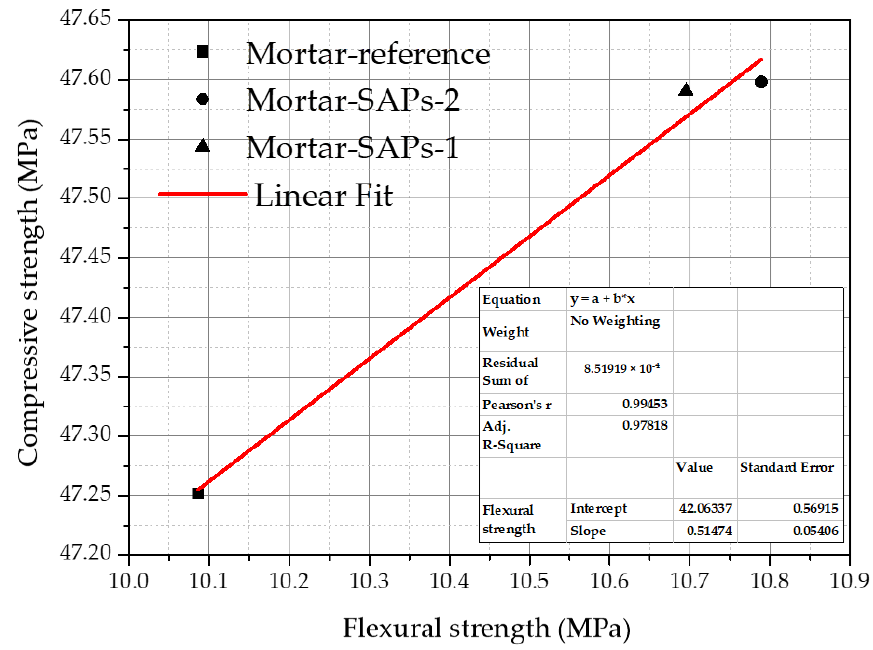
Figure 6. Relationship between compressive and flexural strength of mortar-based materials.